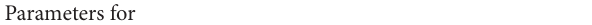
Table 1: Comparative analysis for the selection of the best model for MDM2 protein from Homo sapiens